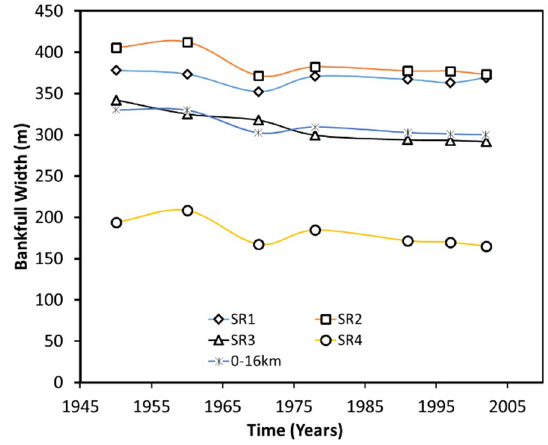
Figure 7. Temporal trends of average channel width in four subreaches.